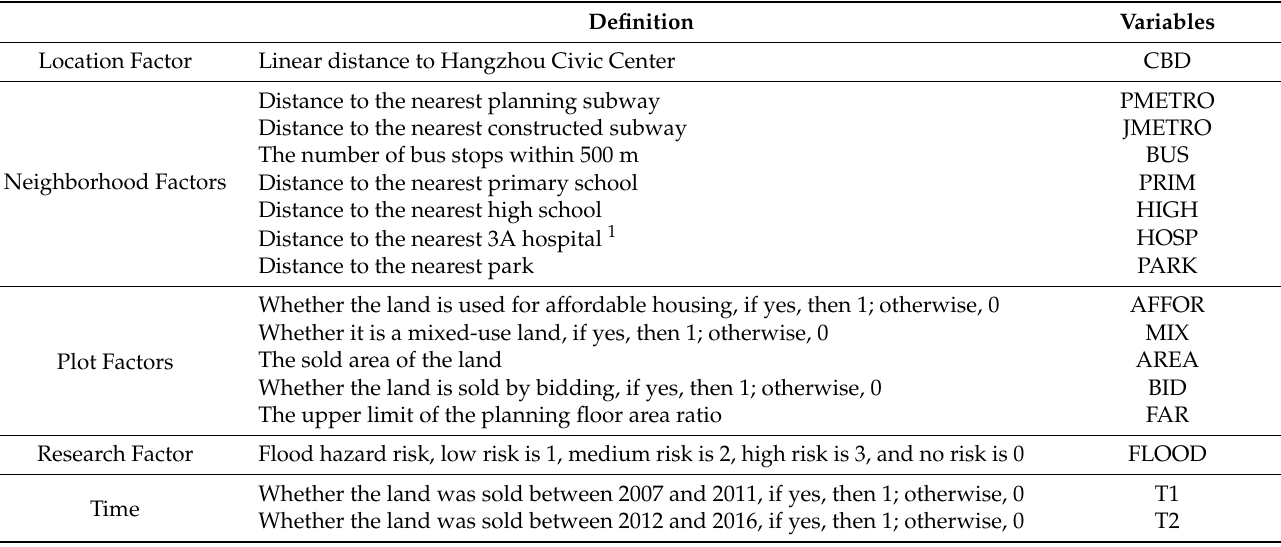
Table 3. Selected variables and